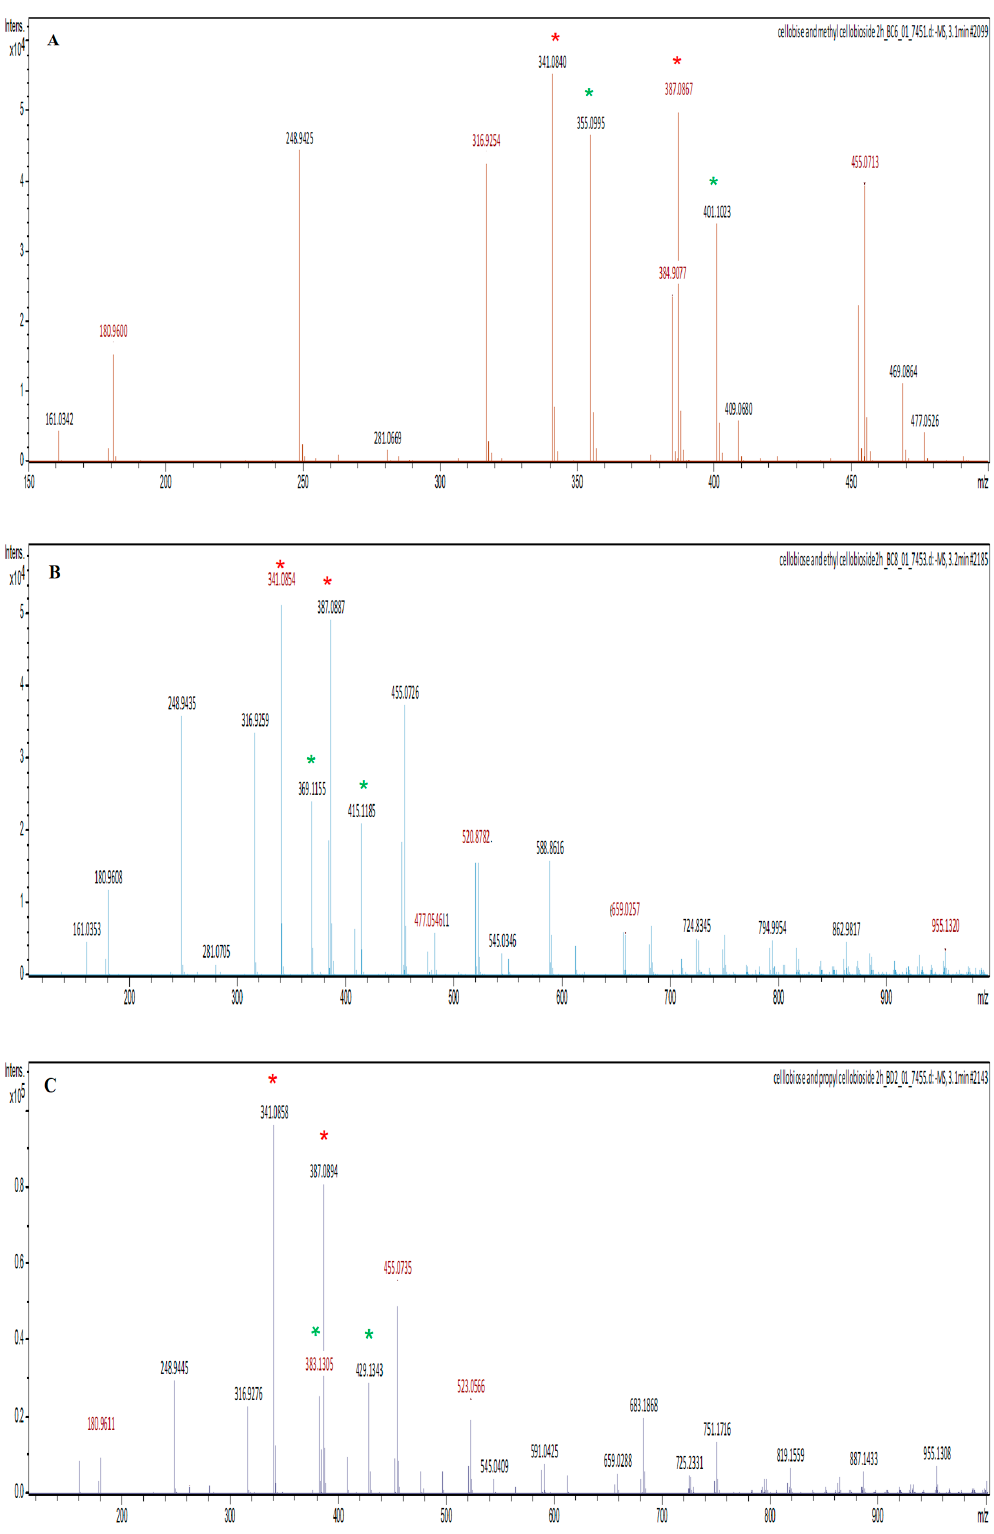
Figure 7. The electrospray ionisation (ESI) profiles of the Exg-D synthesised methyl-, ethyl- and propyl-cellobiosides shown in ( A ), ( B ) and ( C ) , respectively. The red stars represent cellobiose and its formic adduct, while the green stars represent alkyl-cellobioside and their formic